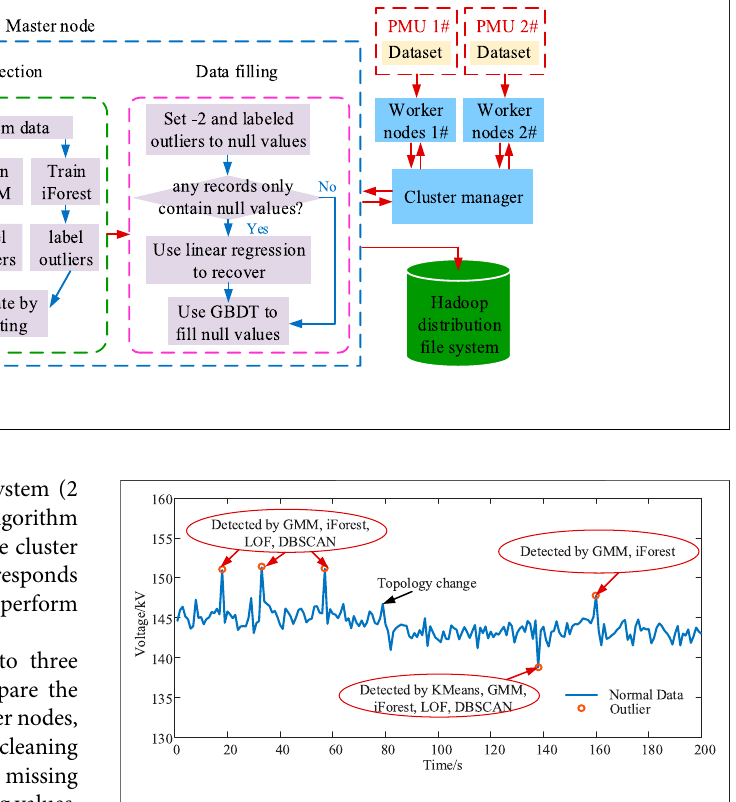
FIGURE 2 | The framework of data cleaning in